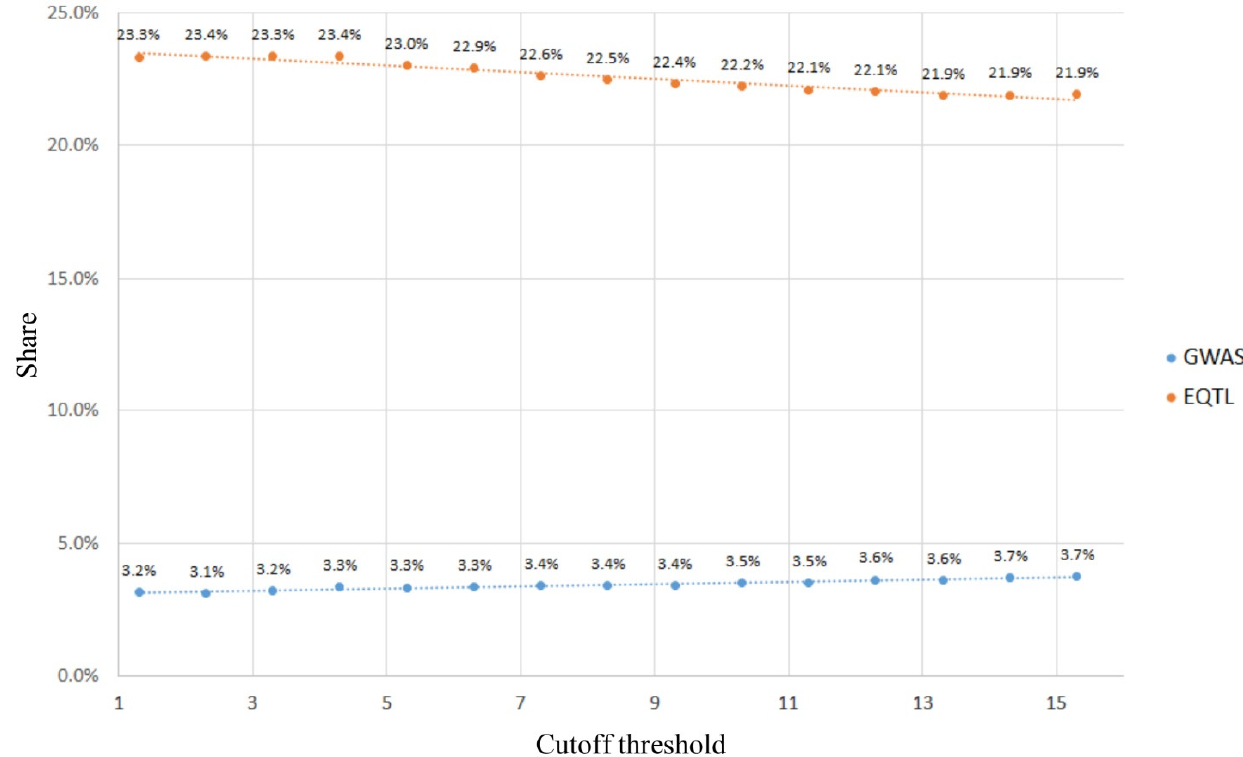
Figure 2. Enrichment of the resulting rSNP set in GWAS phenotype associations and/or eQTLs.The cutoff threshold was − log α , where α is the probability of the first type.